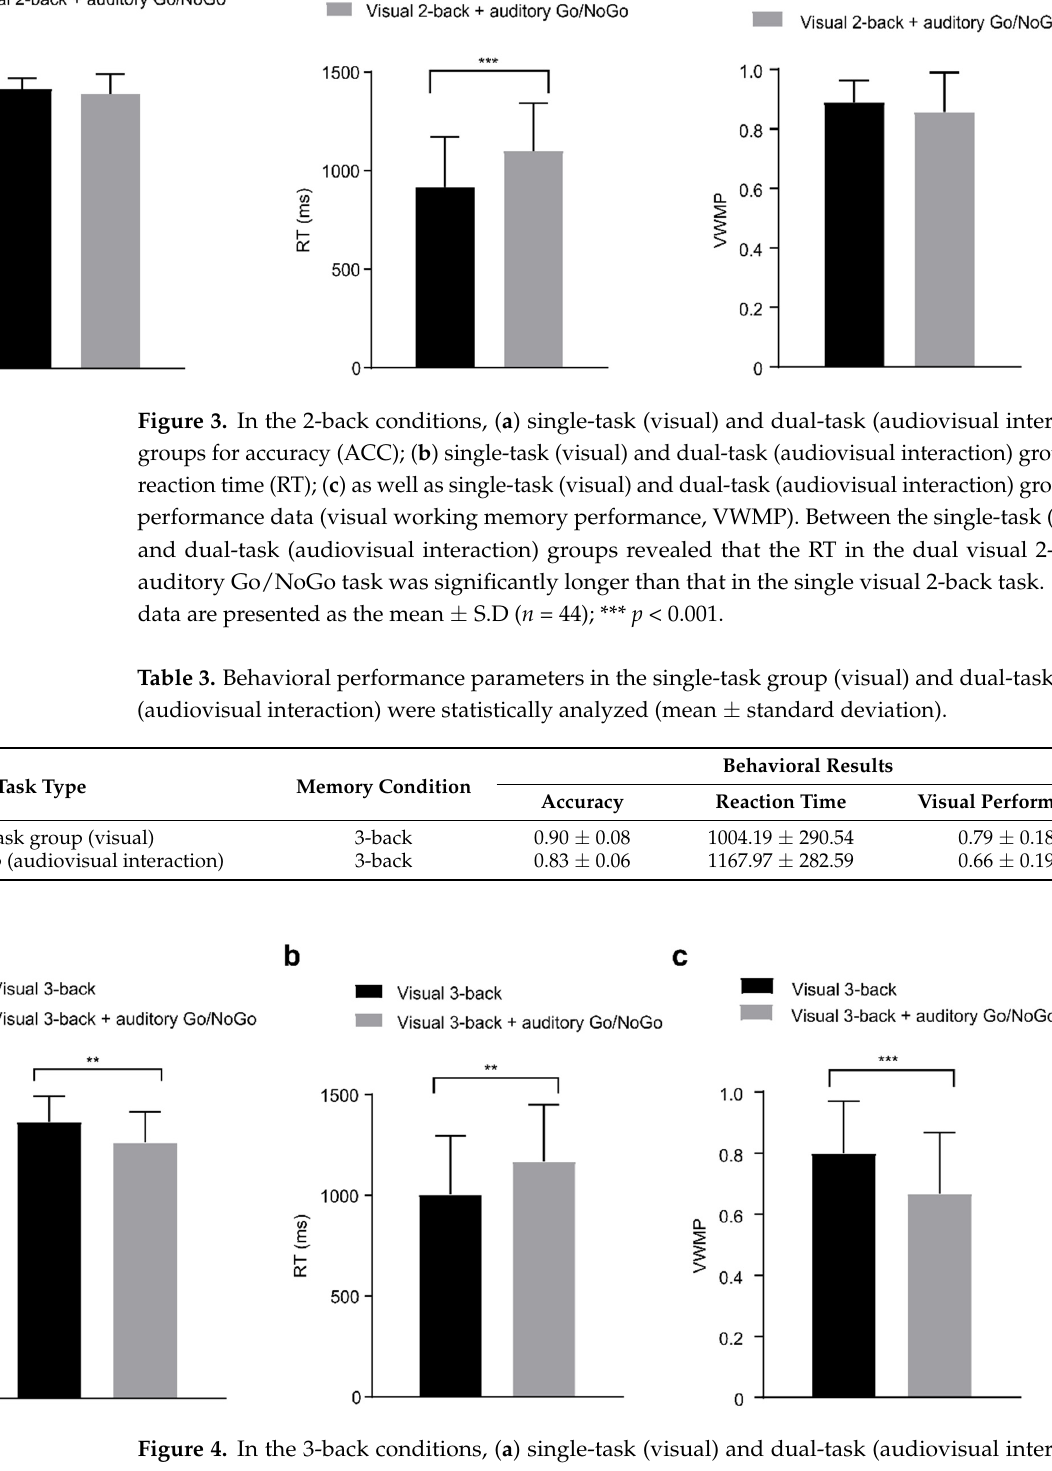
Figure 4. In the 3-back conditions, ( a ) single-task (visual) and dual-task (audiovisual interaction) groups for accuracy (ACC); ( b ) single-task (visual) and dual-task (audiovisual interaction) groups for reaction time (RT); ( c ) as well as single-task (visual) and dual-task (audiovisual interaction) groups for performance data (visual working memory performance, VWMP). There were differences in ACC and RT as well as VWMP between the single-task group (visual) and the dual-task (audiovisual interaction) group. All the data are presented as the mean ± S.D ( n = 44); ** p < 0.01, *** p < 0.001.